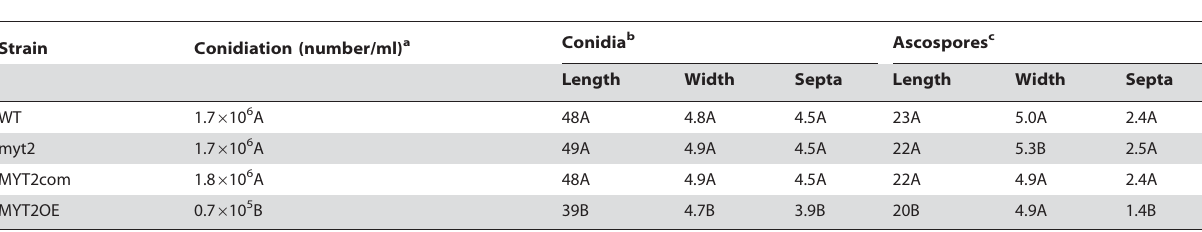
Table 2. Production and morphology of conidia and ascospores.